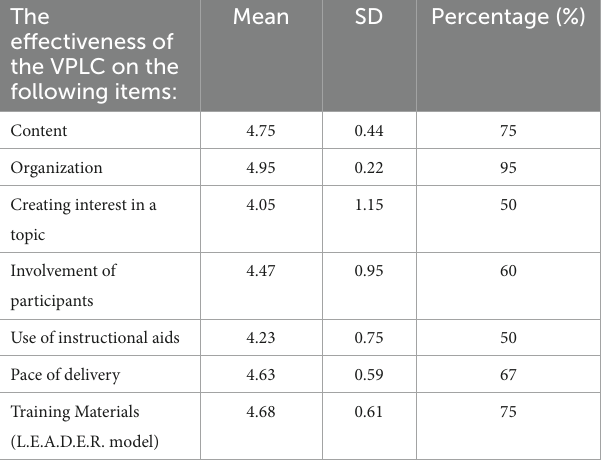
TABLE 2 Descriptive statistics of the effectiveness of the VPLC. The effectiveness of